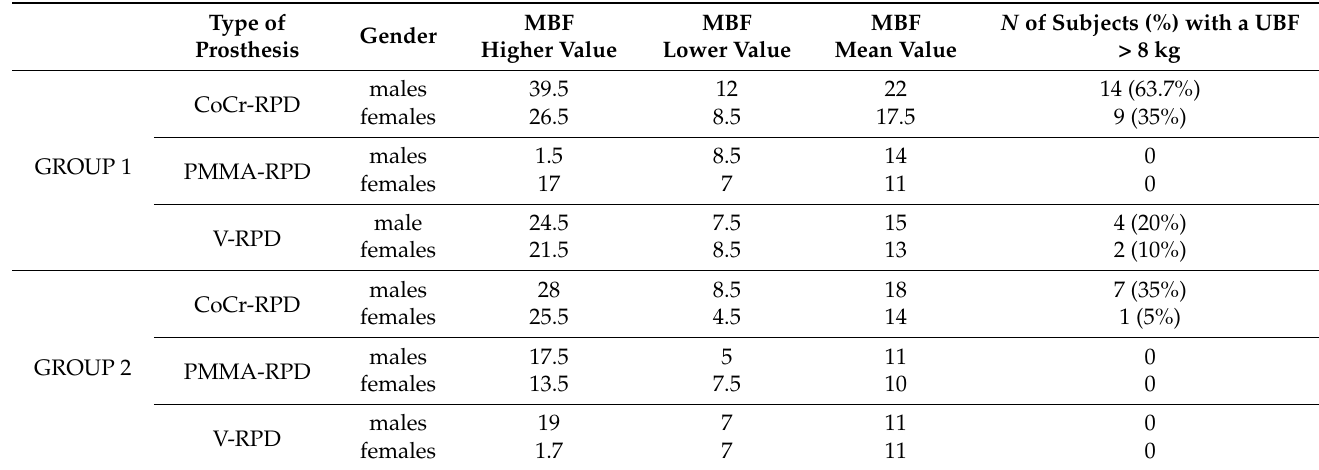
Table 1. Maximum Bite Forces in the 6 subgroups. [MBF = Maximum Bite Force (kg); UBF = Usual bite force (40% of MBF,